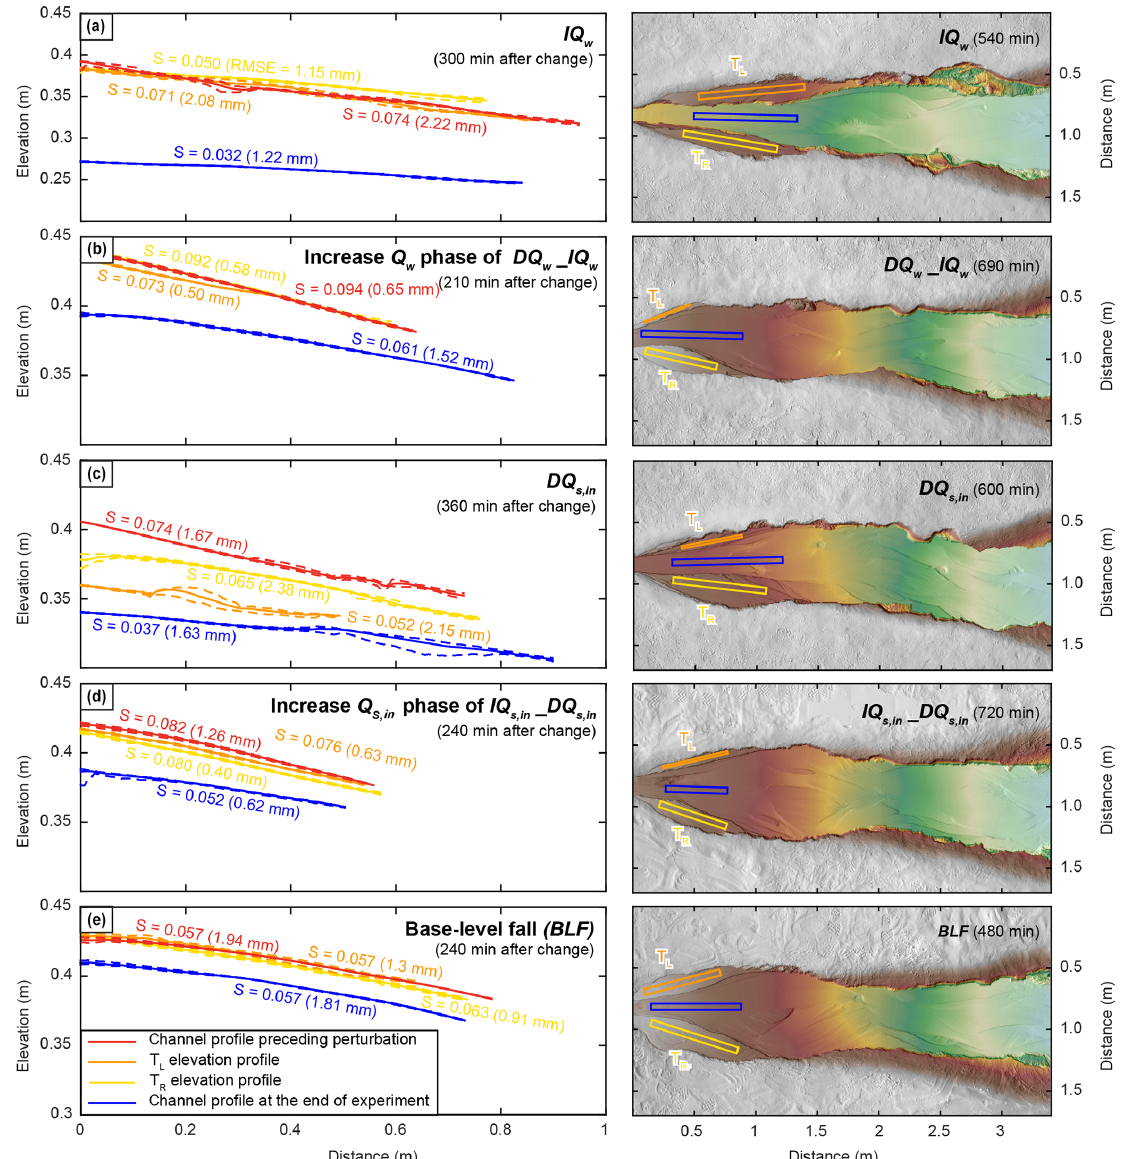
Figure 7. Elevation profile and slope comparison of terrace surfaces and active channels. Elevation profiles are given as mean (solid lines) and minimum and maximum values (dashed lines), extracted along 5cm wide swaths as indicated on the right panel. Swath width was reduced in two cases of too narrow terraces to 1cm (DQ w _IQ w T L terrace) and 2cm (DQ s , in T L terrace). T L and T R indicate terraces on one side each and refer to labels of lag times given in Figs. 3 and 6. Slopes were calculated based on a linear fit through the mean elevation profiles. Numbers in parentheses give the RMSE between the linear fit and the measured data. For the four experiments in which upstream conditions changed (a–d) , the slopes of the terraces are steeper than those of the active channel at the end of the experiment. In contrast, in the BLF experiment, slopes of the terraces and the active channel are about the same. Note the different y axis for the IQ w run that was necessary to display the deep incision. Colors for elevations in the right panel are the same as those in Fig.